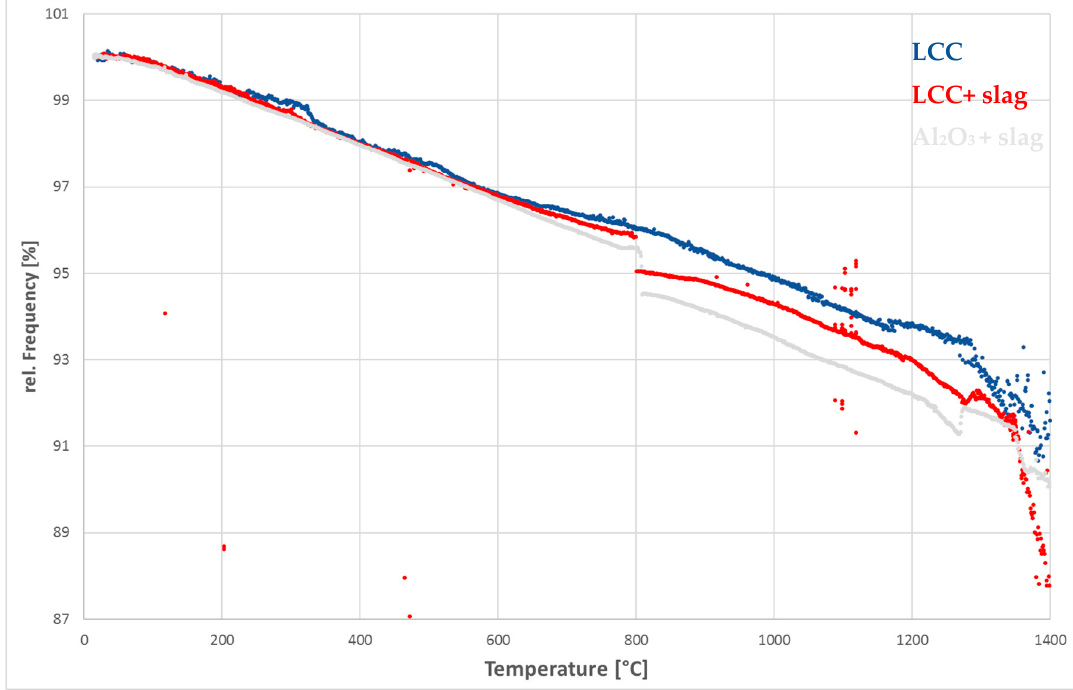
Figure 5. Relative change of frequency against temperature during heating of the reference LCC, the LCC and alumina sample filled with slag.